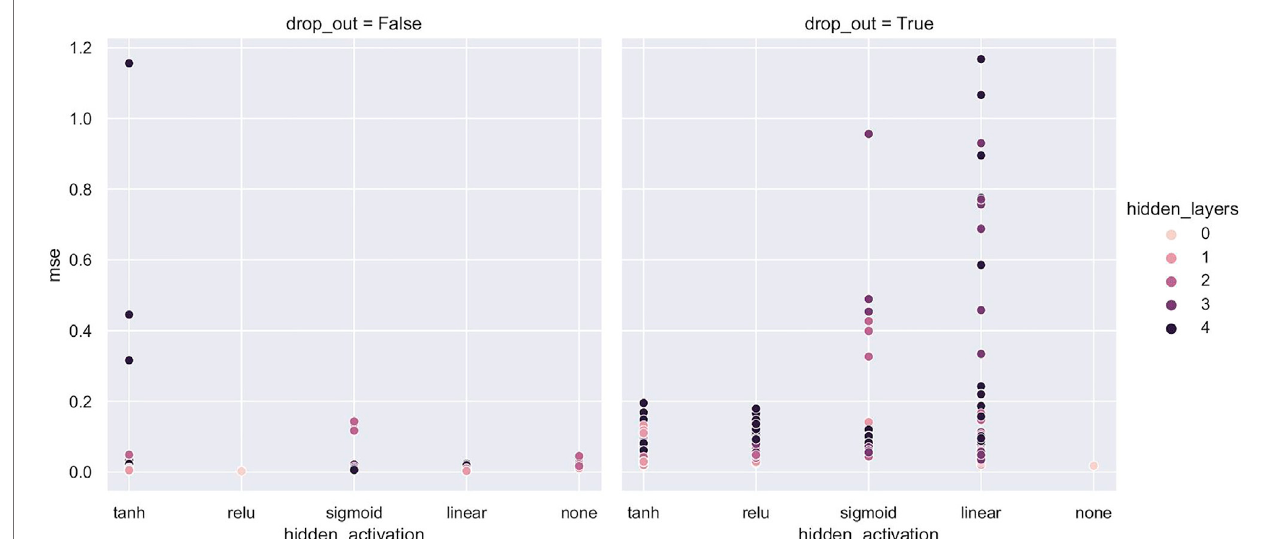
FIGURE 4 | Overview of hyperparameter